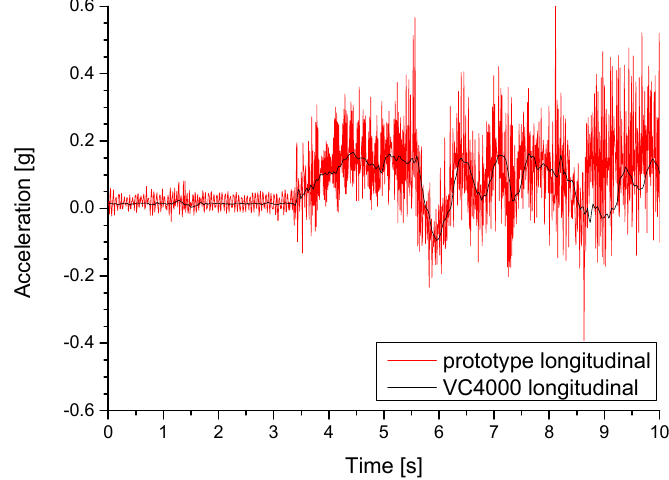
Figure 6. Preliminary test with noise still present in the prototype signal.